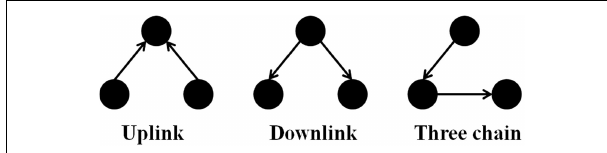
FIGURE 2 | The three-node two-edge motif substructures .